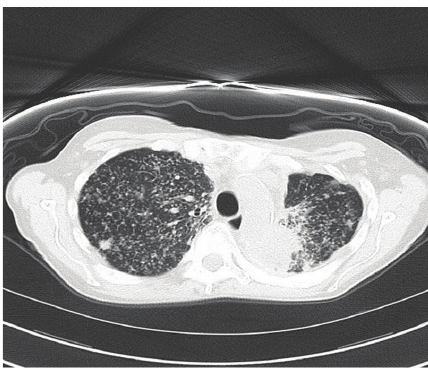
Figure 1: Chest CT without contrast: pulmonary nodules of varying sizes persisting throughout the lung zones, with the largest shown here in the right upper lobe.